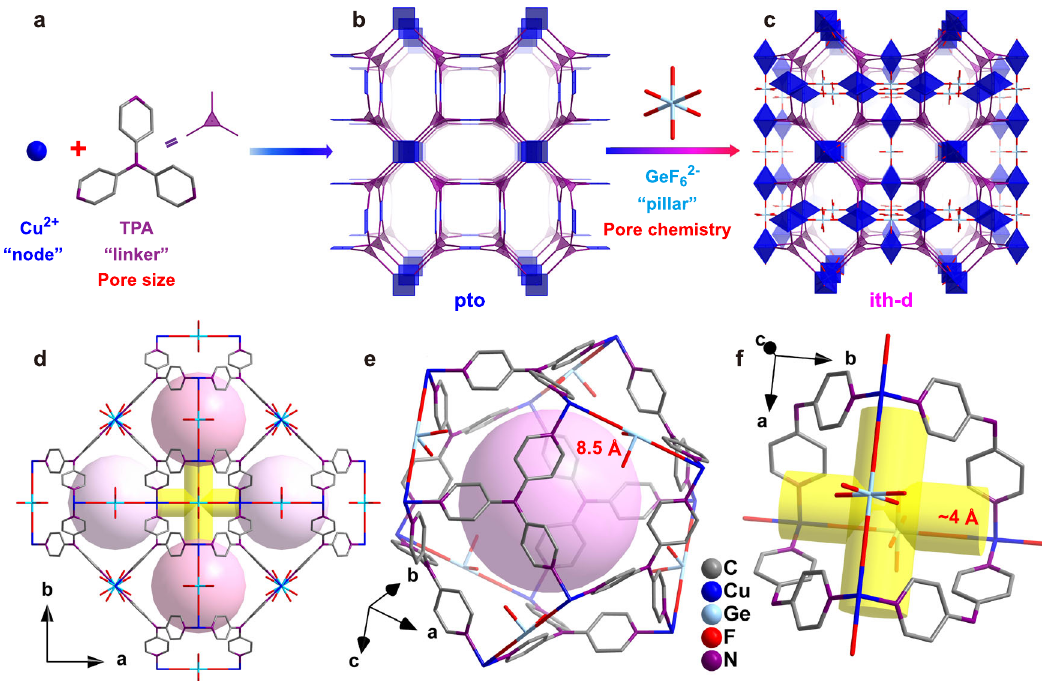
Fig. 1 | Porous structure of ZNU-6. a – c Exquisite control of pore size/shape and pore chemistry in ZNU-6 from pillared (3,4)-connected pto network to GeF 6 2 − embeddedith-dtopologyframework; d OverviewofZNU-6structurewithcage-like